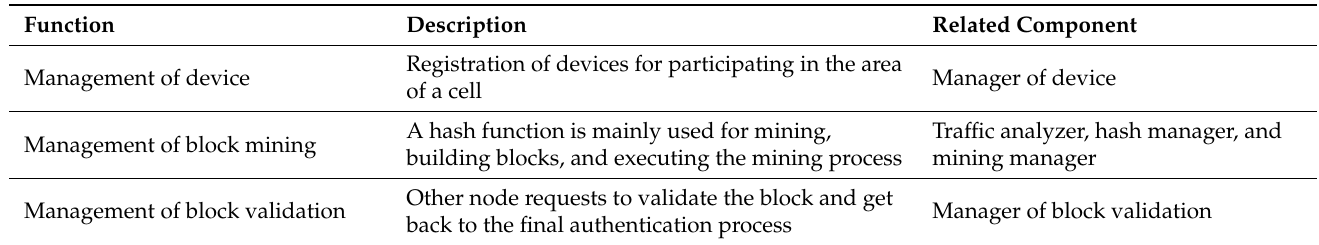
Table 3. Function and related components of cell